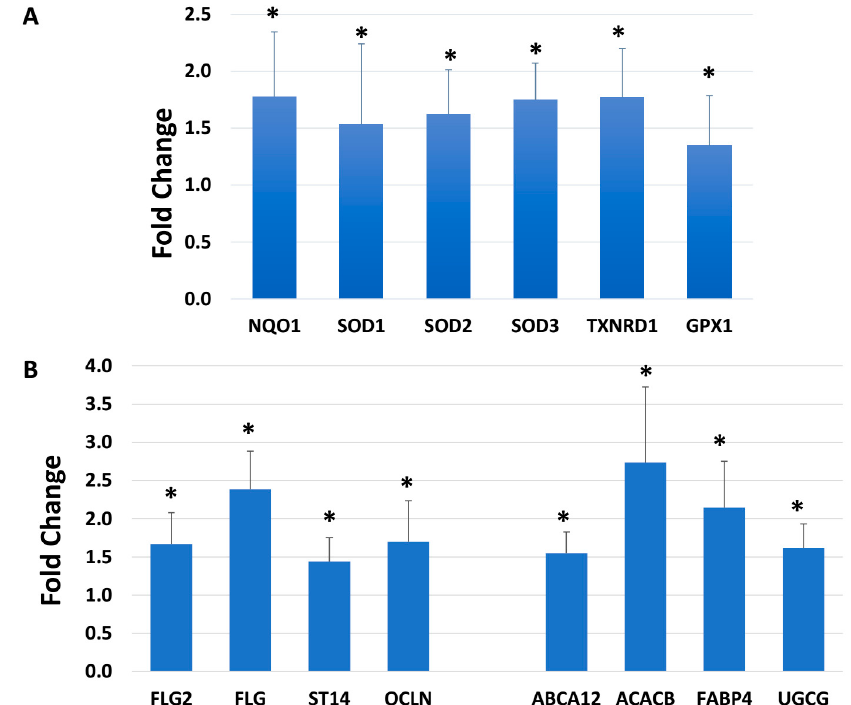
Figure 1. Modulation of gene expression. Skin equivalents were dosed with BlendE for 24 h. Four hundred forty validated Taqman gene expression assays with relevance to the skin structure and function were examined using OpenArray. Unpaired t -tests were performed using StatMiner, and only statistically-significant fold changes compared to the untreated samples were shown ( p ≤ 0.05). Standard deviation is shown as error bars. ( A ) Gene expression changes on selected oxidative stress targets are shown. ( B ) Gene expression changes on selected skin barrier targets are shown. * indicates statistically-significant increase compared to control values.